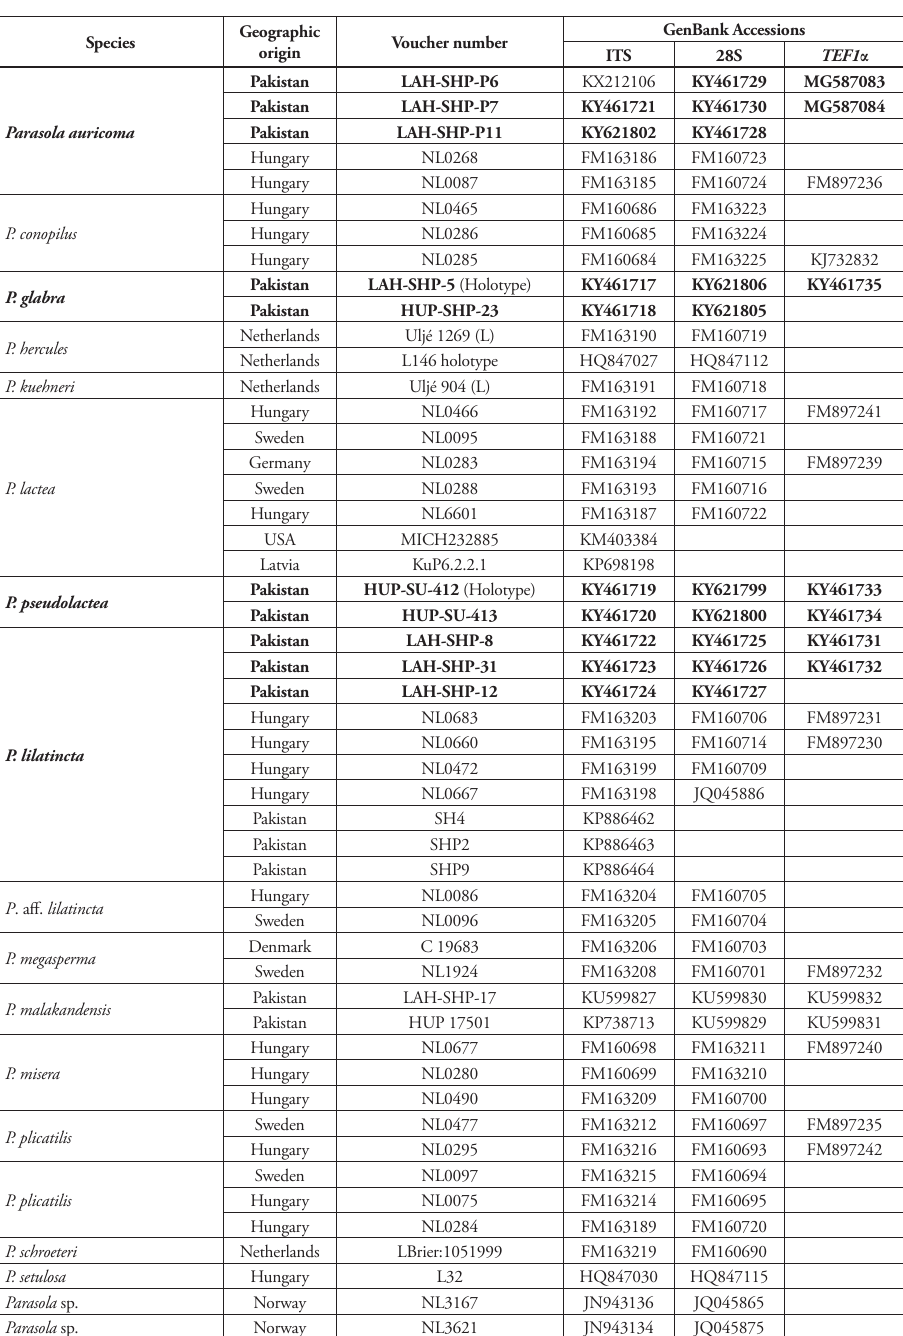
Table 1. Voucher numbers, geographic origins and GenBank Accession numbers for the specimens in- cluded, in boldface are sequences produced in this